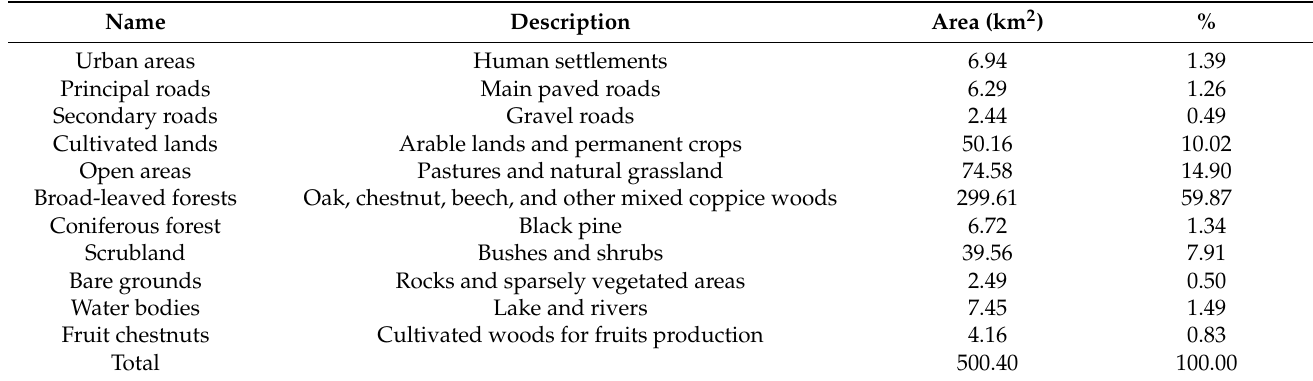
Table 1. Land-covers of the study area.